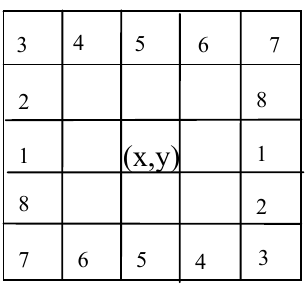
Figure 2. Eight directions of a